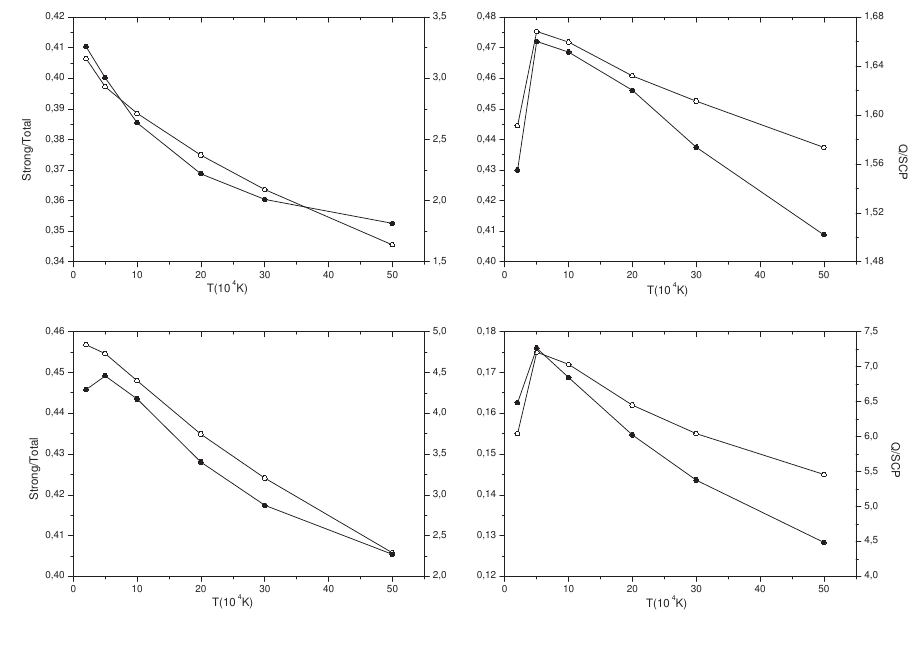
3 P o − 3s4d 3 D 3 ( left down ), and 3s3p 2